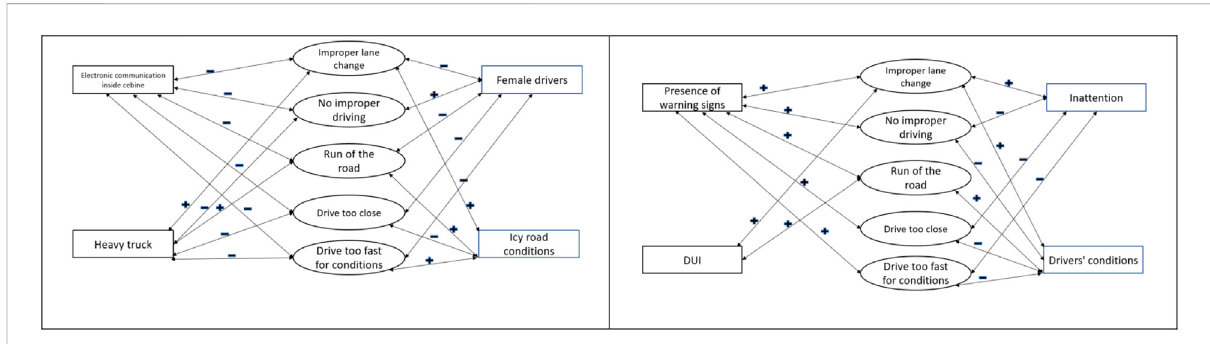
FIGURE 1 Associations between various considered variables and different drivers ’ actions and RUM model, with other types of drivers ’ actions as reference.